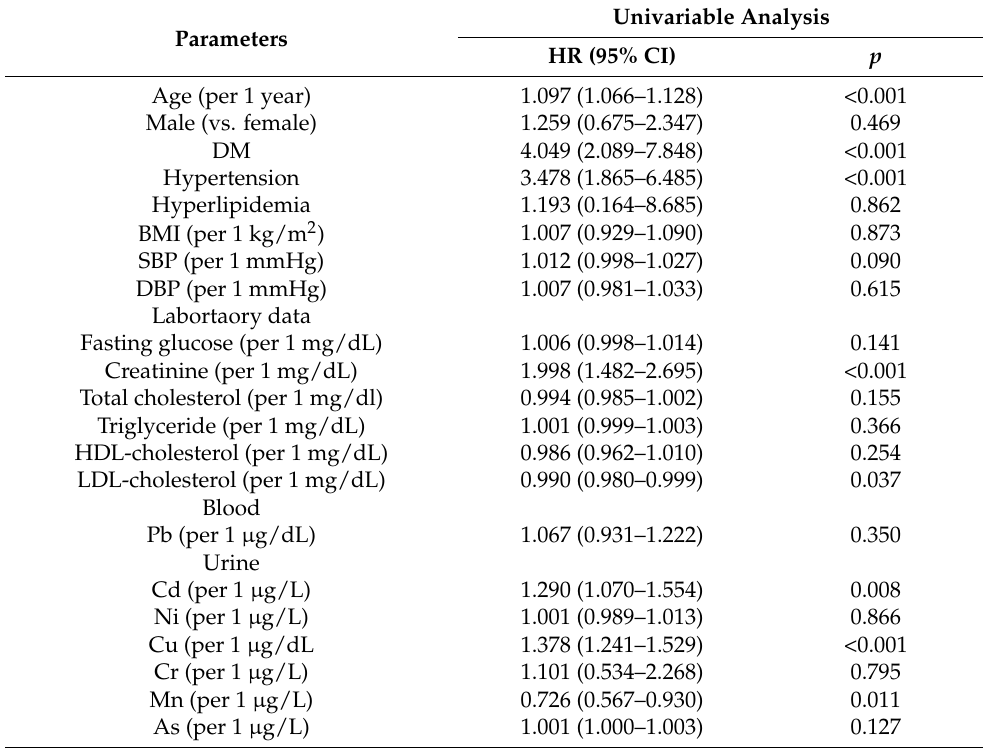
Table 2. Predictors of overall mortality using Cox proportional hazards